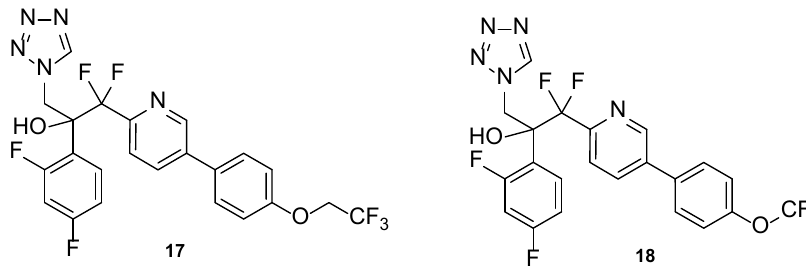
Figure 14. Chemical structures of VT-1161 ( 17 ) and VT-1129 ( 18 ) [72] .